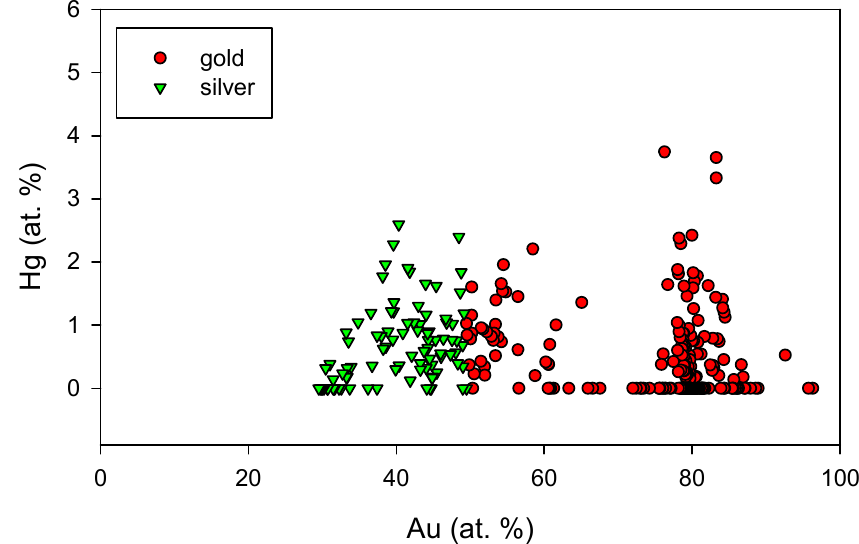
Figure 14. Chemical composition of members of Au-Ag solid-solution in an Au versus Hg (at. %) plot.